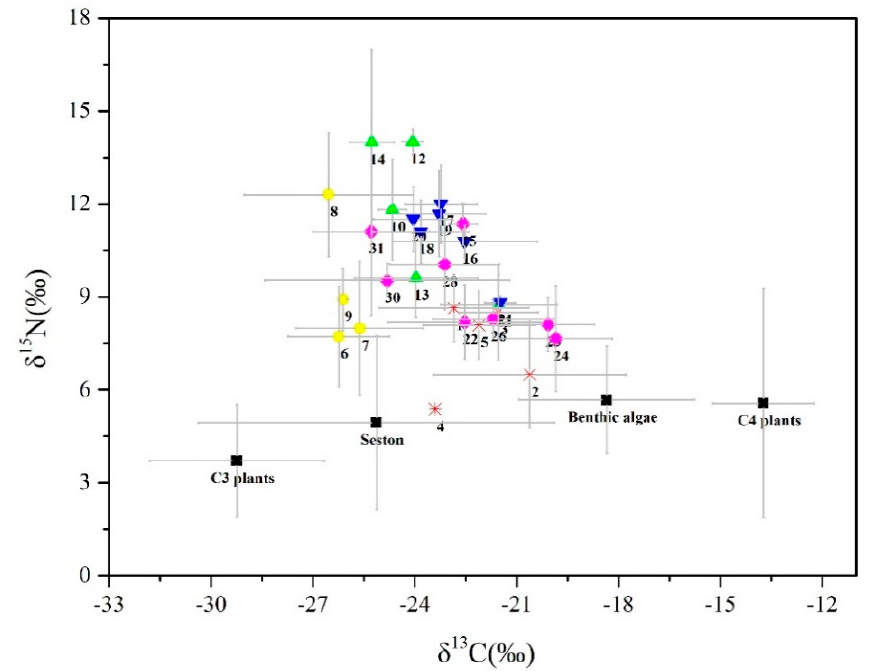
Figure 2. Biplot of δ 13 C and δ 15 N values (mean value and standard deviation) of basal organic carbon sources and fish collected from the downstream (backwater zone) of the Daning River. The fish species code was in accordance with Table 1. Black square, organic matter sources; green triangle, benthivores; blue inverted triangle, piscivores; violet diamond, omnivores; yellow dot, planktivores; red star, herbivores.